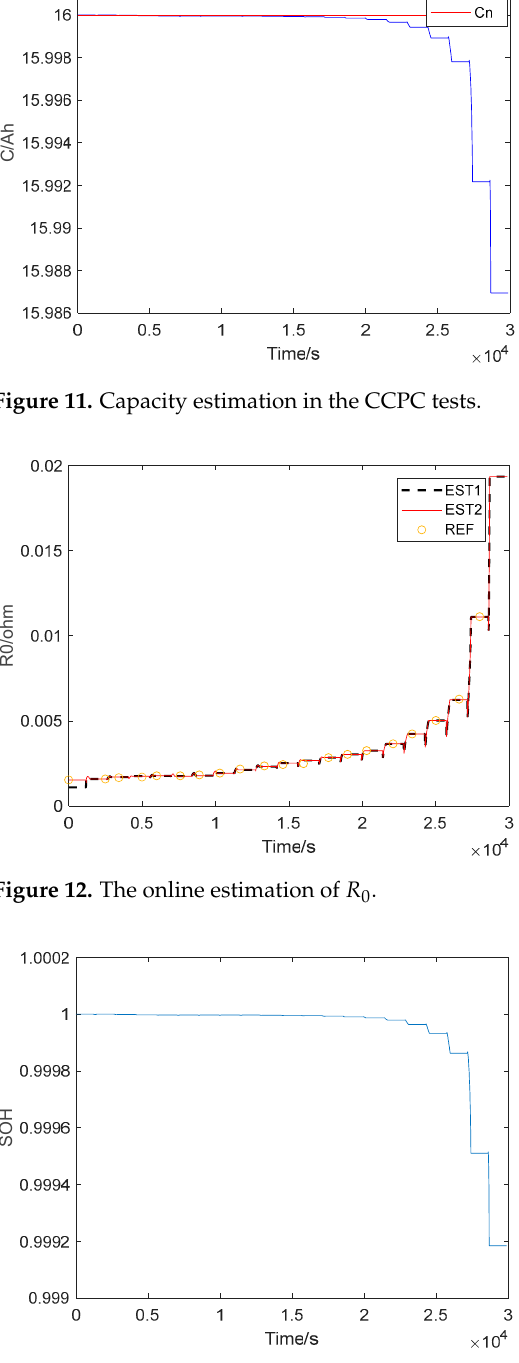
Figure 13. The predicted results of the SOH.